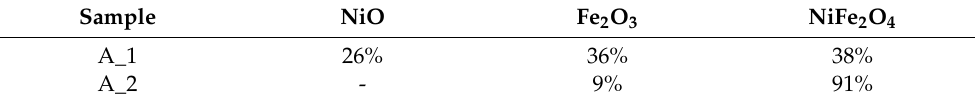
Table 2. Composition of the samples A_1 (600 ◦ C for 48 h) and A_2 (800 ◦ C for 48 h).